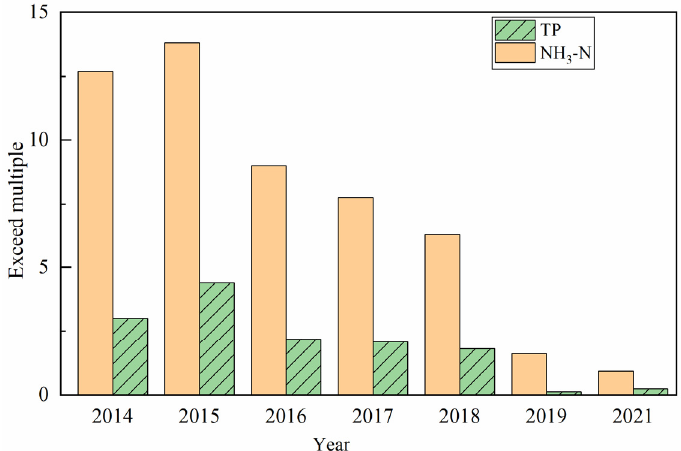
Figure 6. Exceeding multiples of ammonia nitrogen (NH 3 -N) and total phosphorus (TP) in Yitong River of Changchun City from 2014 to 2021.